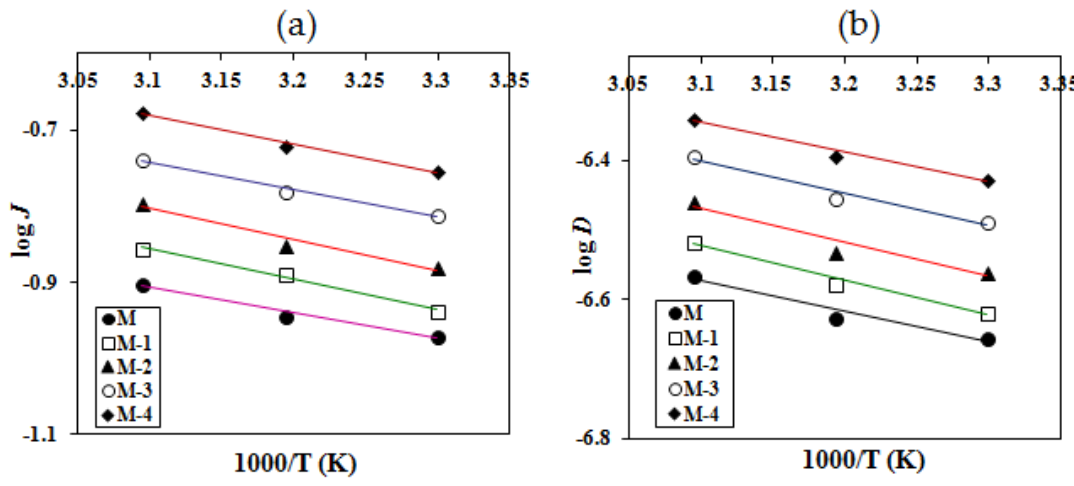
Figure 8. Variation of ( a ) log J and ( b ) log D with temperature for crosslinked sodium alginate and related nanocomposite membranes with 10% water in the feed.